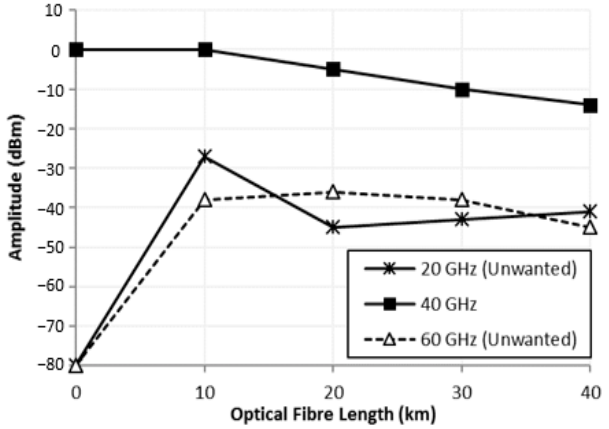
Figure 8. mm-wave amplitudes vs. fiber lengths.